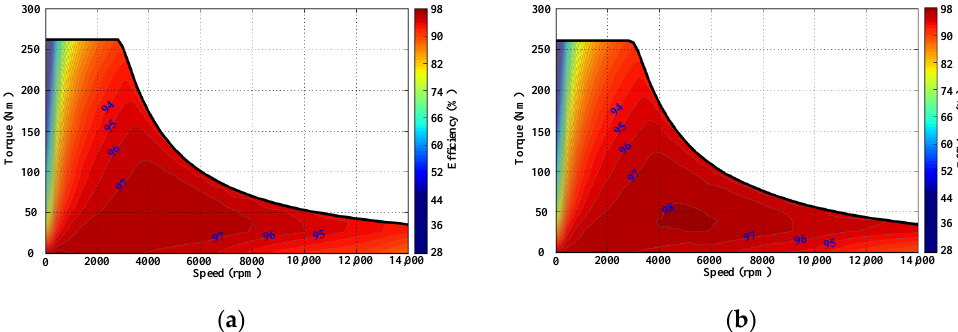
Figure 12. Iron losses versus speed curves.